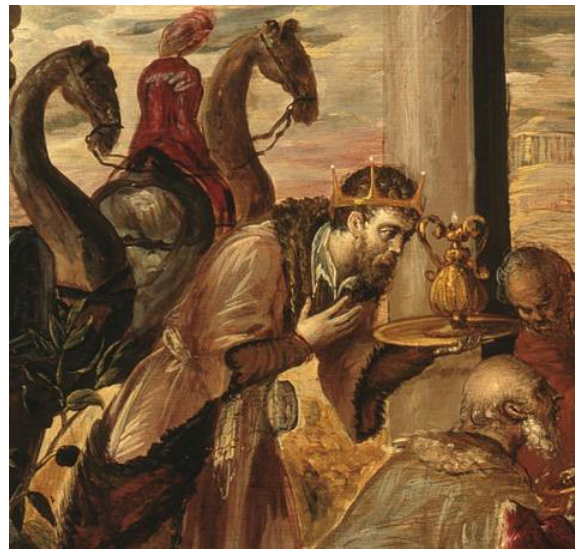
Figure 1. Detail from El Greco, Adoration of the Magi (1568), Museo Soumaya, Mexico City. Public domain (Greco 1568).